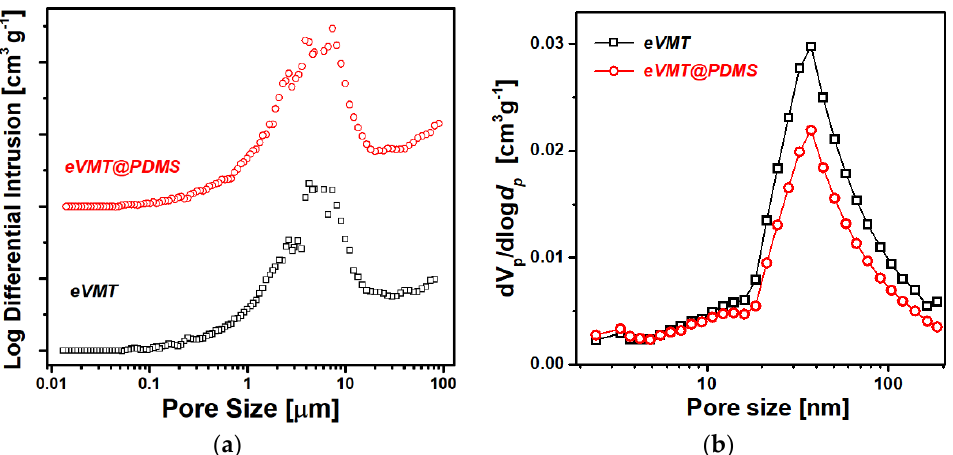
Figure 3. Pore size distributions of eVMT and eVMT@PDMS obtained from ( a ) Hg porosimetry and ( b ) N 2 adsorption isotherm.